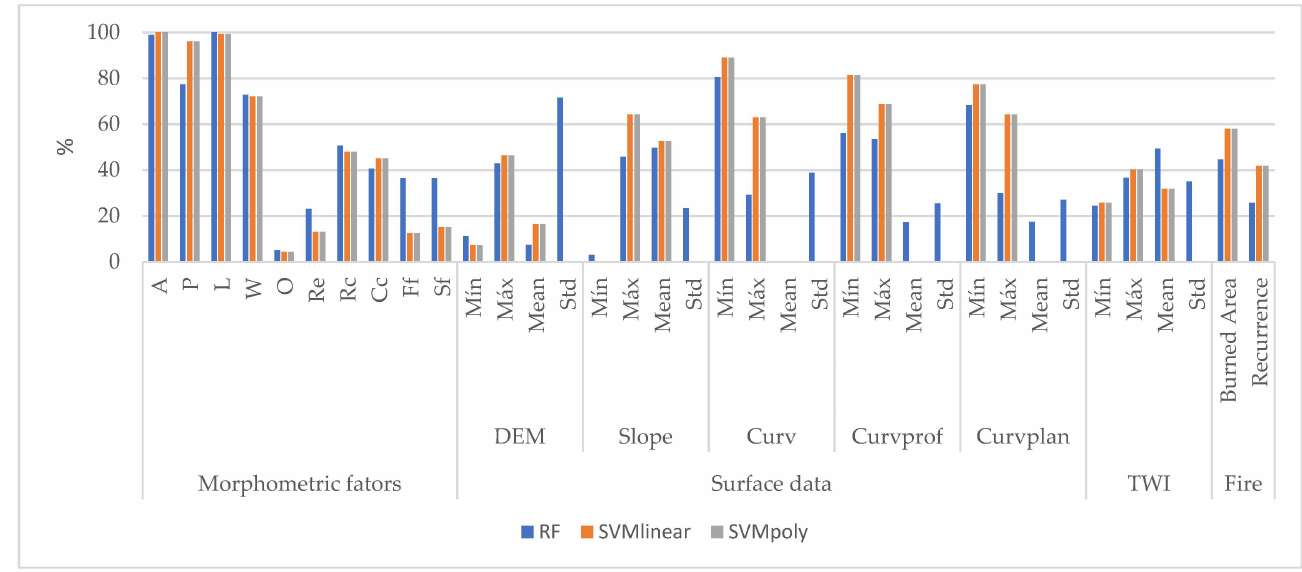
Figure 2. Importance of variables in machine learning